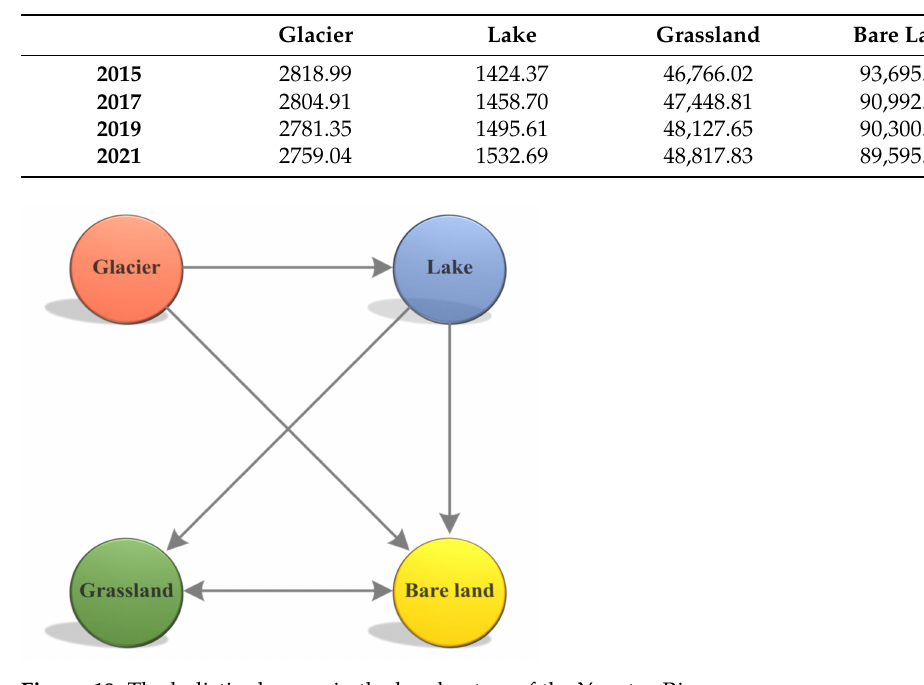
Figure 19. The holistic changes in the headwaters of the Yangtze